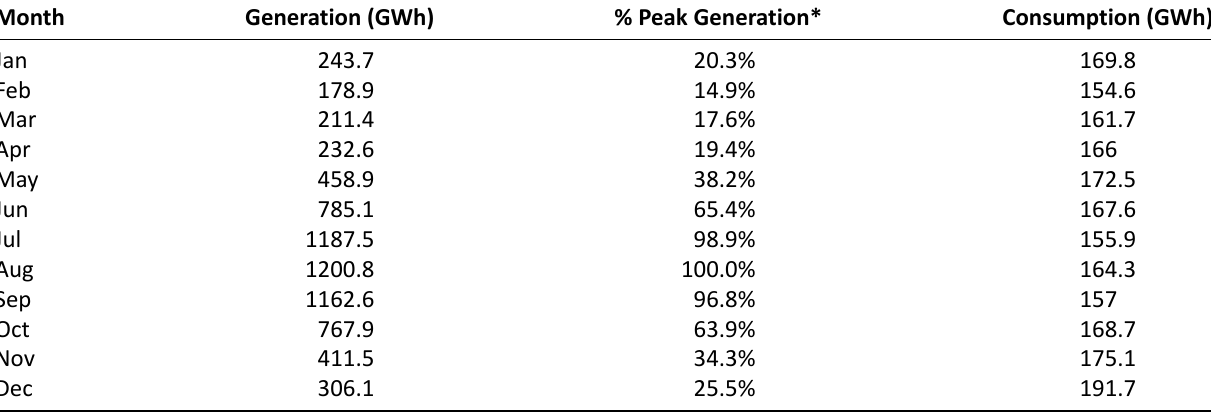
Table A4. Monthly electricity generation and consumption in 2014 based on Druk Green Power Corporation (2014) and BPC, Personal Communication, January